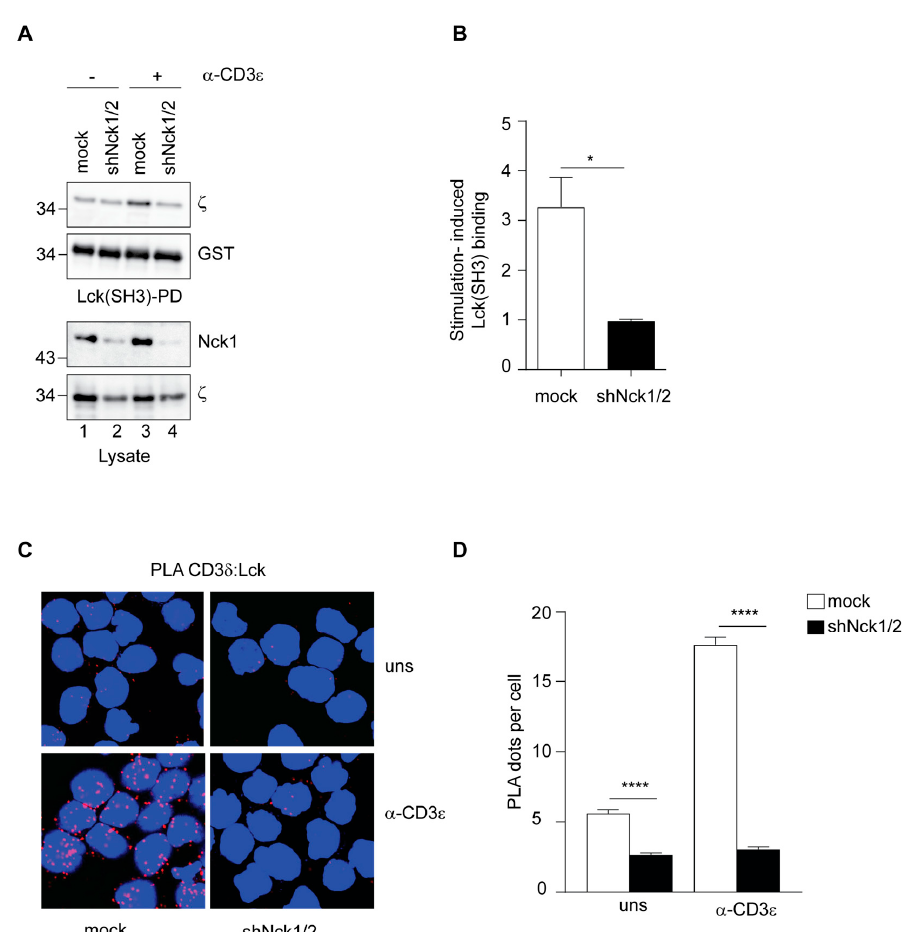
Figure 3. Nck facilitates Lck binding to the TCR. ( A ) The total cell lysate of unstimulated (-) or anti-CD3 ε (OKT3) antibody stimulated (+) mock-treated and shNck1/2 Jurkat cells was subjected to a pull-down assay with GST-Lck(SH3)-coupled beads followed by immunoblotting with the indicated antibodies. Lysates served as control to show Nck1/2 downregulation. One representative experiment is shown. ( B ) The stimulation-induced binding of the TCR to Lck(SH3)-beads was calculated from three independent experiments performed as in A and analyzed using an unpaired Student’s t -test. ( C ) In situ PLA between the TCR (CD3 δ ) and Lck was performed. Jurkat mock-treated or shNck1/2 cells were either left unstimulated (uns) or stimulated for 5 min at 37 ◦ C with 10 µ g/mL anti-CD3 ε antibody (OKT3). One representative experiment out of three is shown. ( D ) Quantification of the experiment shown in C and analysis using an unpaired Student’s t -test. Mean values ± SEM are shown. * p < 0.05, **** p <